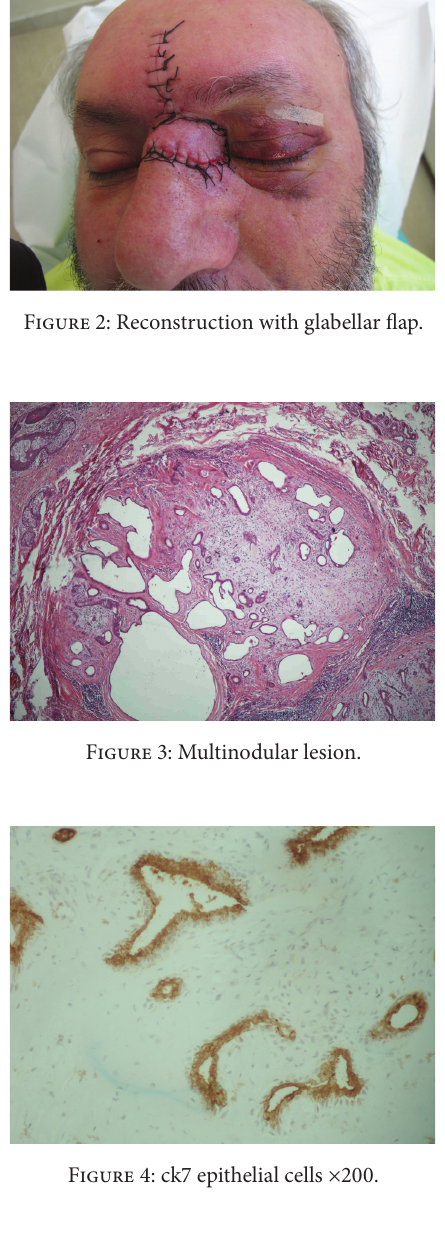
Table 1: Location of the reported cases the last 20